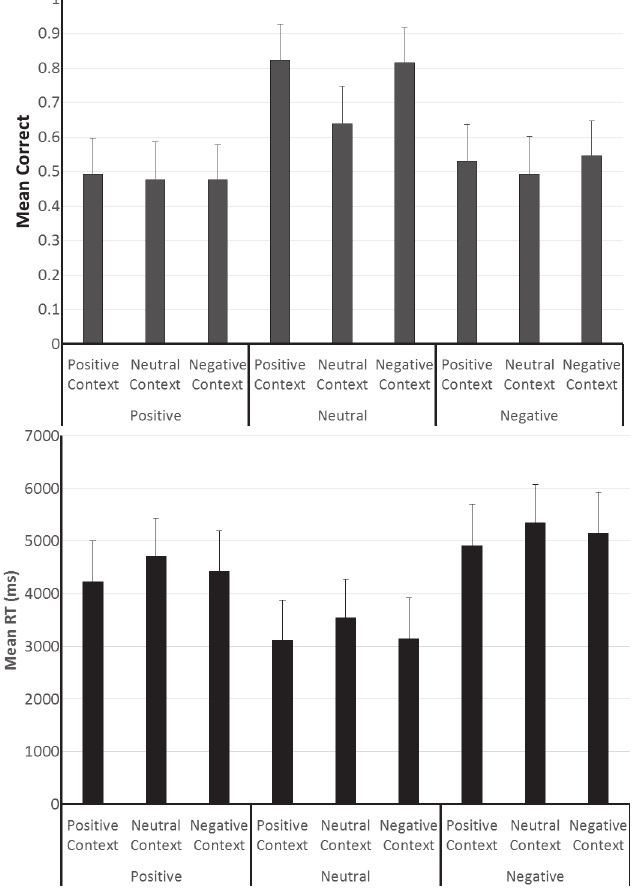
Fig 4. Prospective memory task performance in Experiment 2. The figure shows prospective memory task accuracy (top panel) and speed (bottom panel) as a function of the valence of the pictures used as prospective memory task cues, and the valence of the pictures used for creating the positive, neutral and negative context conditions. The error bars represent the 95% confidence interval for each mean.